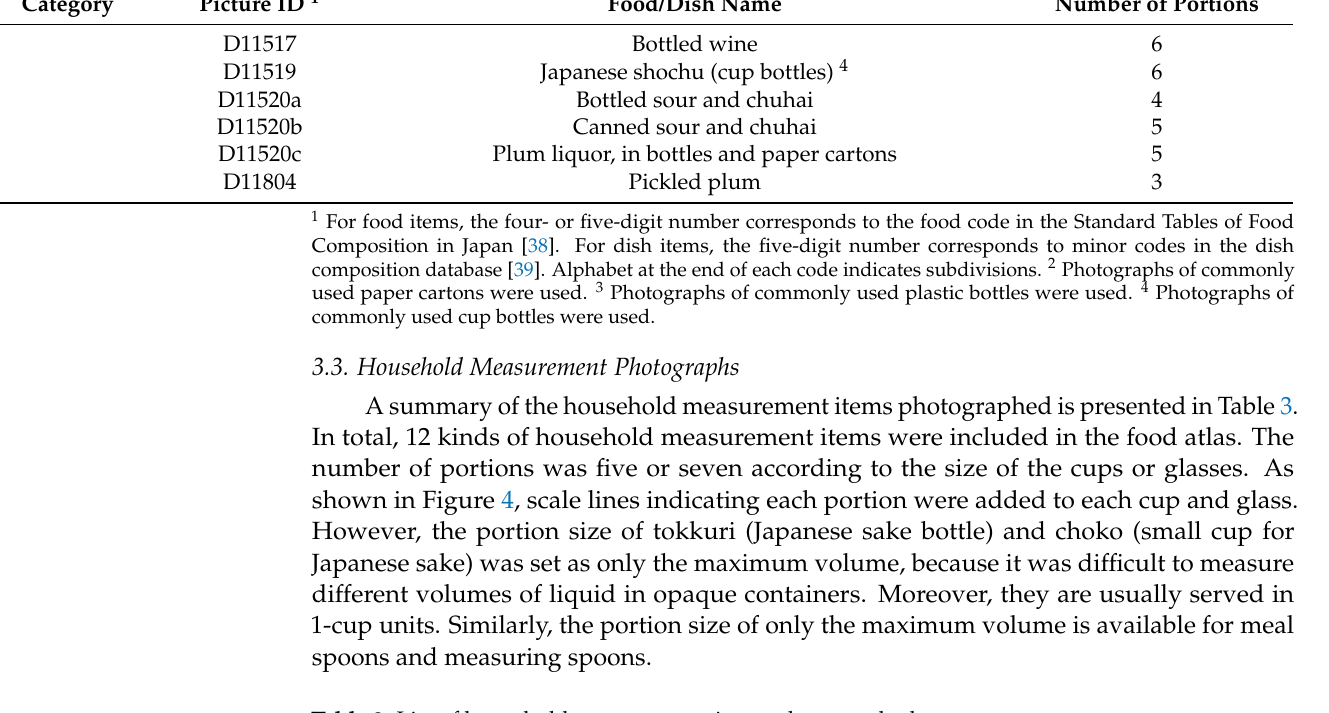
Table 3. List of household measurement items